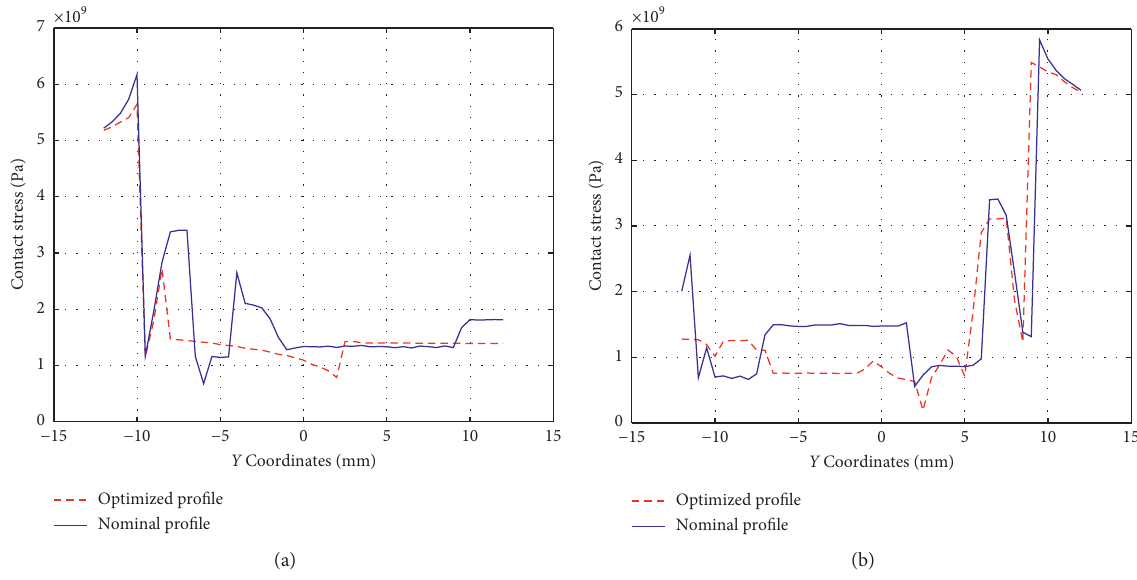
Figure 14: Maximum wheel-rail contact stress before and after optimization: (a) switch rail and (b) stock